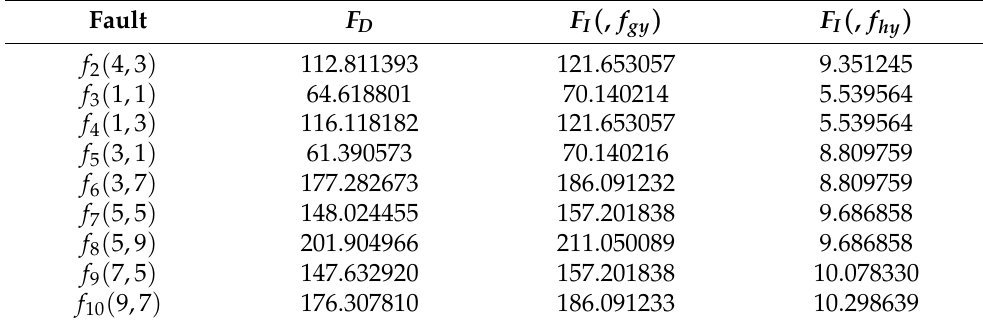
Table 3. Diagnosability indexes on a fault information manifold for compound faults.